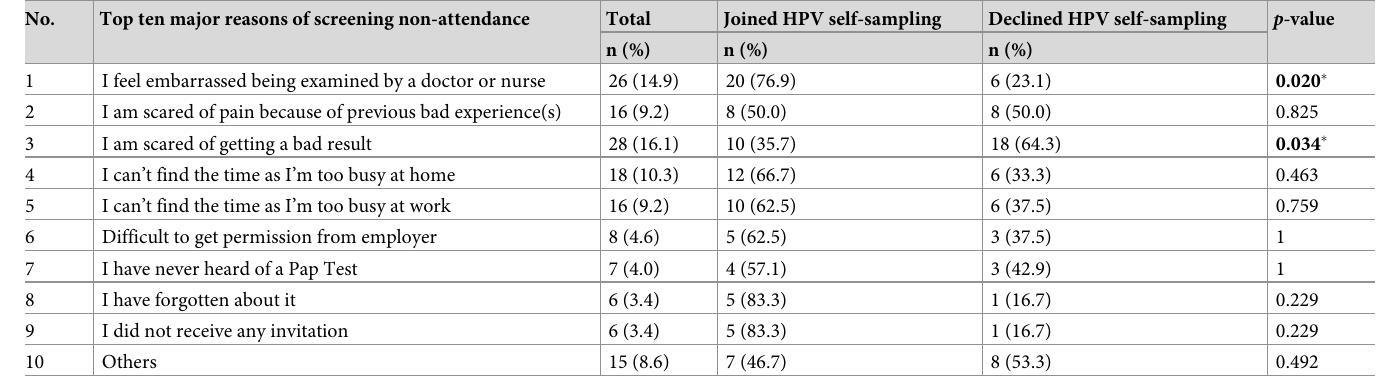
Table 2. The top ten major reasons of not attending cervical cancer screening at JPSHC, Brunei (Jan–Dec 2019), with comparison between those who agreed and declined HPV self-sampling. Responses from 146 participants (83.9% of the total study population) were included. No.